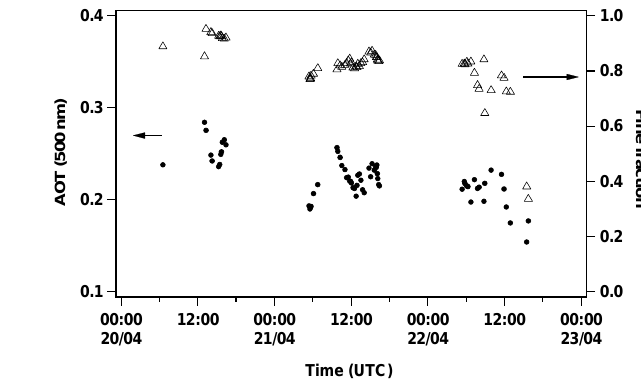
Figure 6 (M. R. Perrone) Fig. 6. Time evolution from 20 to 22 April 2010 of the aerosol op-